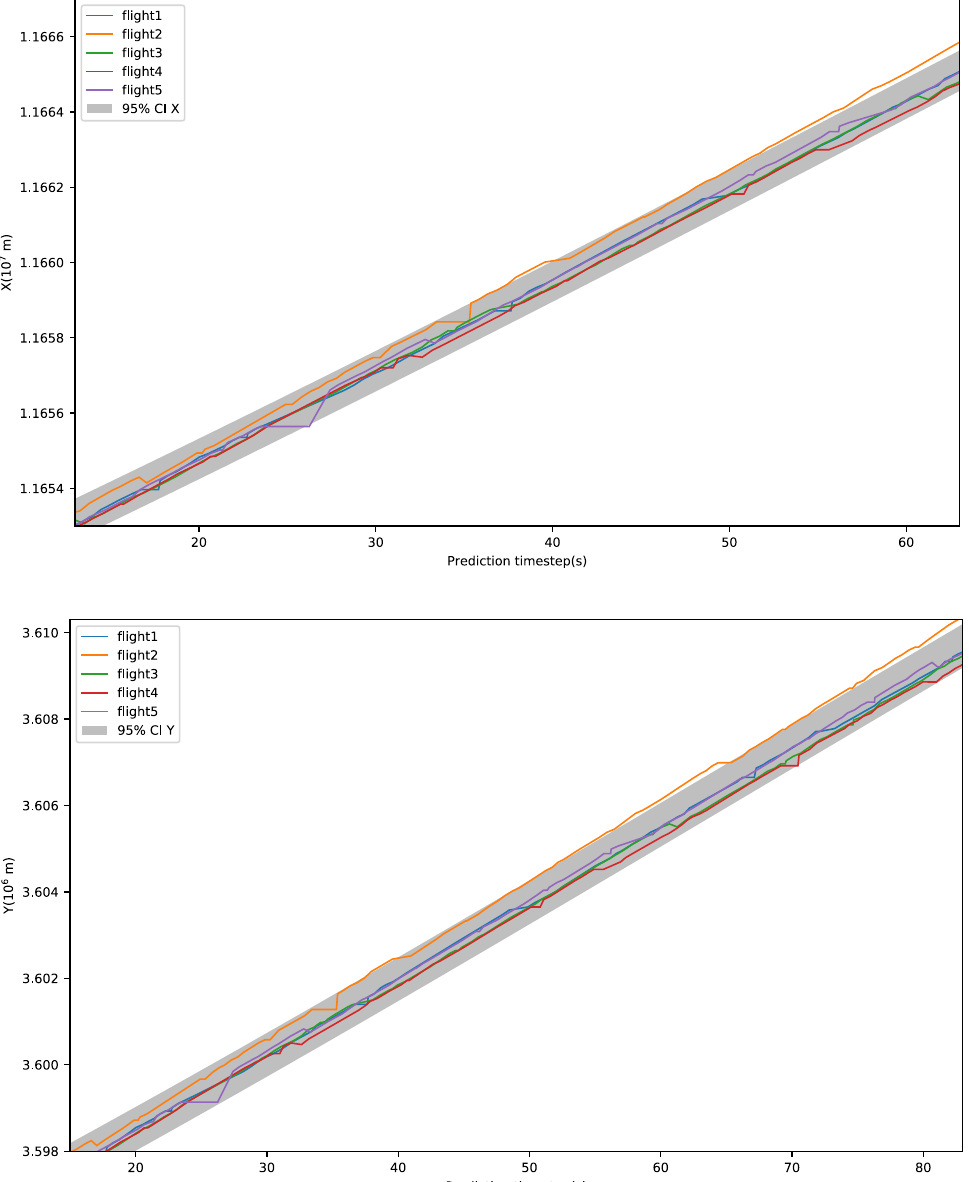
Figure 8. CIs (95%) of the predicted trajectory for a cruise flight (up: X dimension; down: Y dimension).